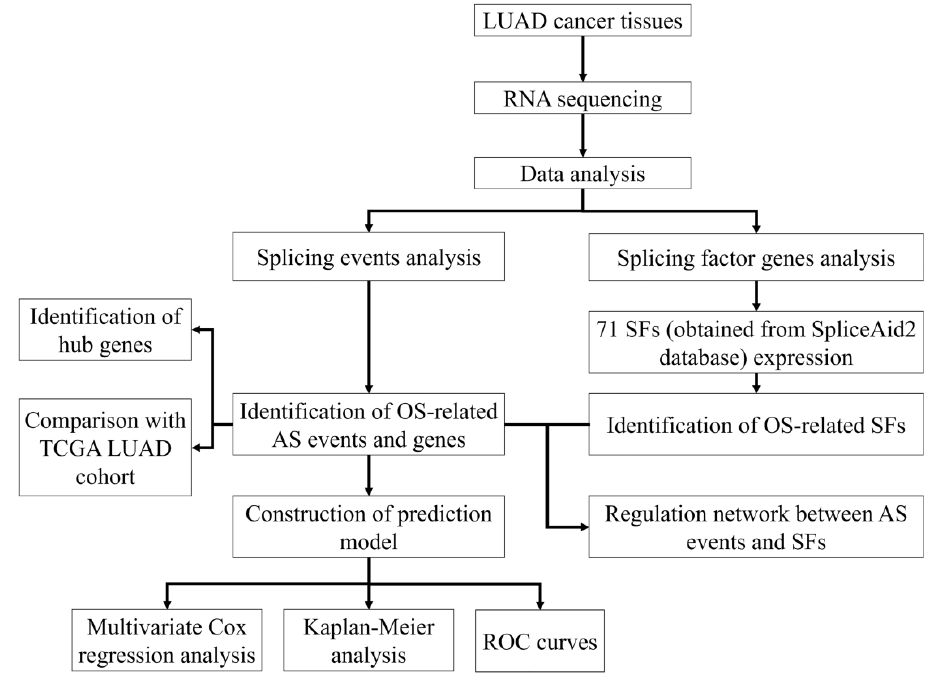
Figure 1. Flowchart of the study design.